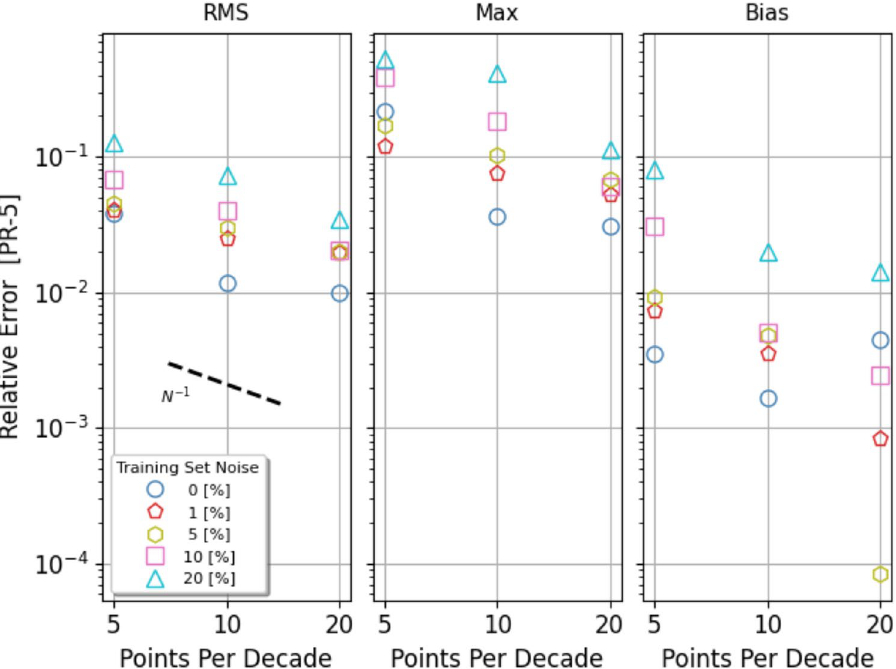
Figure 8. Trend with data sampling density: Test-errors’ RMS (left), Max (center) and Mean (left) presented in the top three panels of Fig. 7, relative to the PR-5 domain, plotted as a function of N ppd . Different symbols correspond to models trained with data characterised by different pre-regularization noise (see Figure’s legend). The error statistics appear to roughly decrease as the inverse of the parameter N ppd (black dashed line).